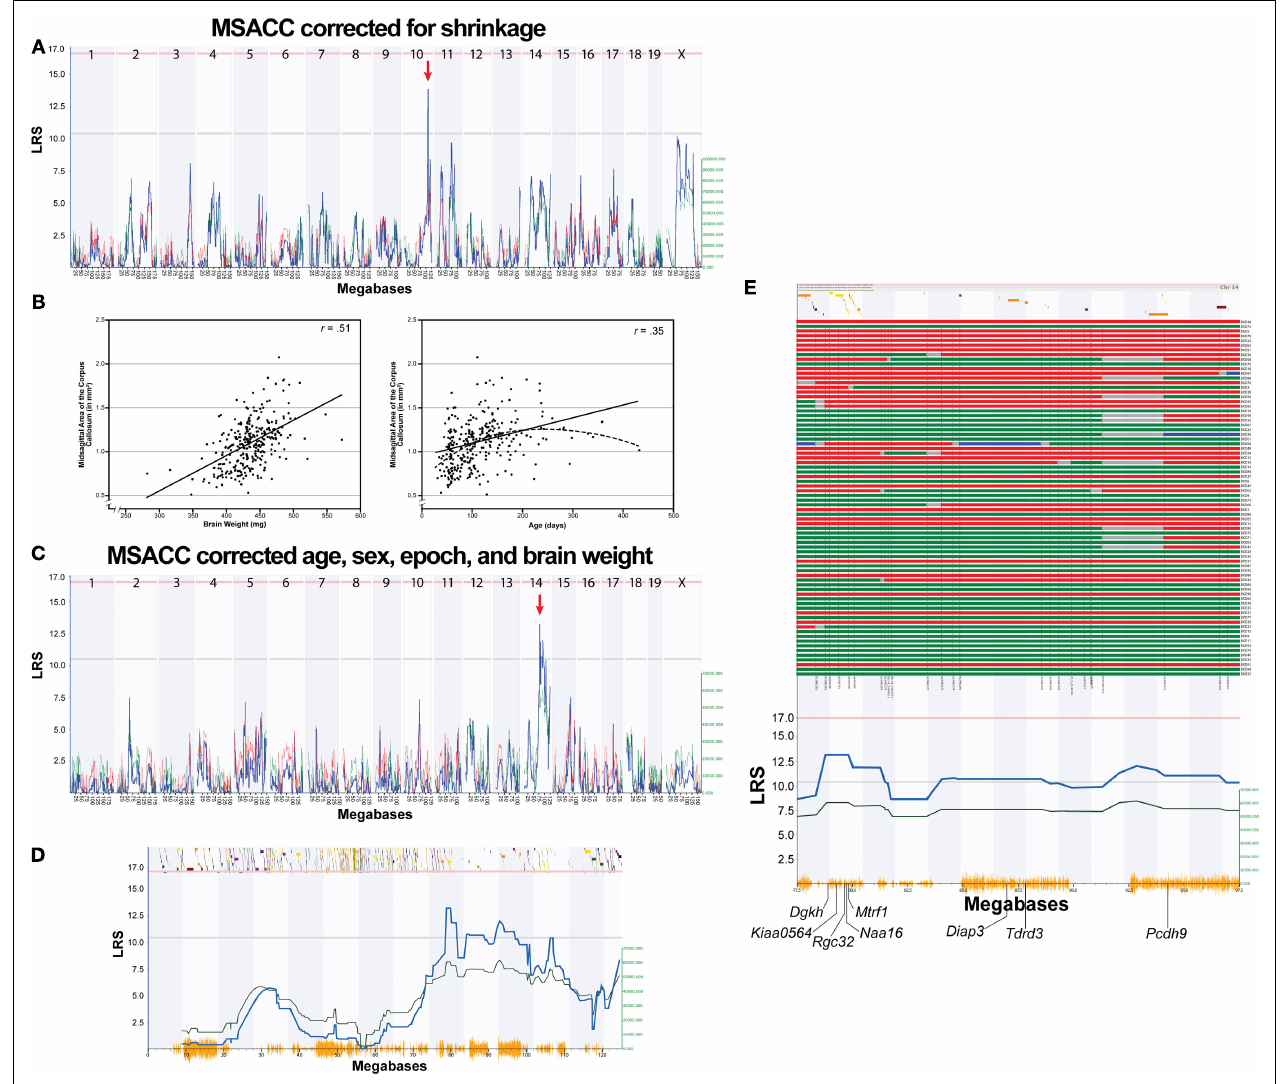
variables. (C) Interval map of MSACC corrected for shrinkage with the effects of age, sex, epoch, and brain weight regressed out.There is a suggestive QTL on Chr 14 (red arrow). (D) Interval map of all of Chr 14. Green line indicates contribution of DBA/2J alleles. Orange lines on x -axis represent high density SNP map. Discontinuous track along the top are the genes on this chromosome. (E) Haplotype map of all 76 BXD strains on 20Mb QTL interval on Chr14 (77.5–97.5Mb). Red lines indicate C57BL/6J alleles (maternal), green lines indicate DBA/2J alleles (paternal), blue lines indicate heterozygous alleles, and gray lines are unknown. Strains are arranged from smallest to largest MSACC (top to bottom).